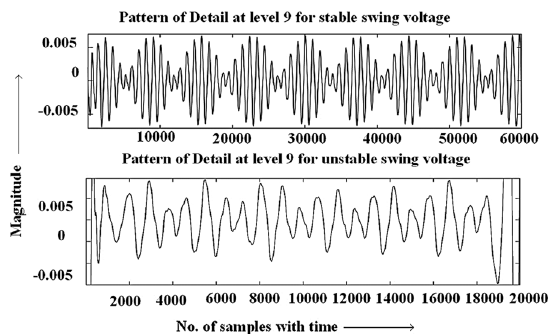
Fig. 5 Pattern difference at level 9 in detail resolution of voltage during the events